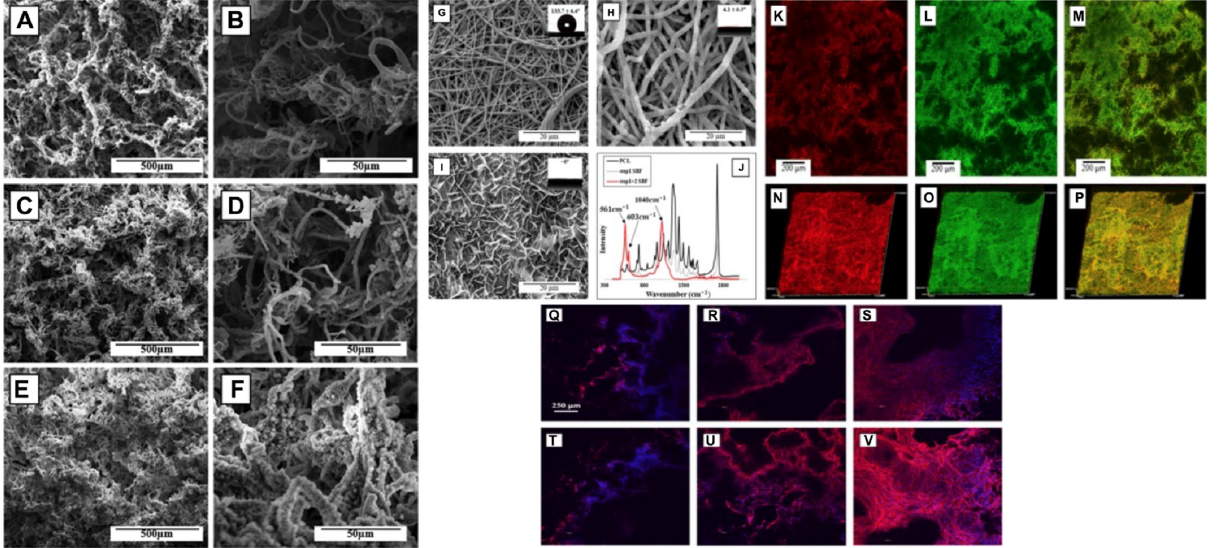
Figure 11. Composites comprising PCL developed by an electrospinning-based thermally induced self-agglomeration (TISA) technique. SEM morphology displaying representative PCL-3D scaffolds in low ( A – C ) and high ( D – F ) magnification. Rows top to bottom visualize neat PCL, step 1 coating, and step 2 SBF coating. FE-SEM image and contact angles of NF PCL mats before immersing in either SBF step ( G ), after step 1 ( H ), and after both steps ( I ). ATR spectra of NF PCL mats prior to and after SBF treatment ( J ). Confocal microscopy of PCL/HA scaffolds of individual layers ( K – M ) and 30 µ m 3D-cross sections ( N – P ). Fluorescent dyes were introduced into step 1 SBF with rhodamine B in red colour and FITC-BSA in green. C2C12 morphologies on TISA (top row) and TISA/HA composite (bottom row) scaffolds, after 24 h ( Q , T ) and 72 h ( R , U ) of culture. ( S ) and ( V ) show a 100 µ m z-stack of cell morphologies after 72 h of culture in individual scaffold. Reprinted with permission from Ref. [174], Copyright 2021, Elsevier